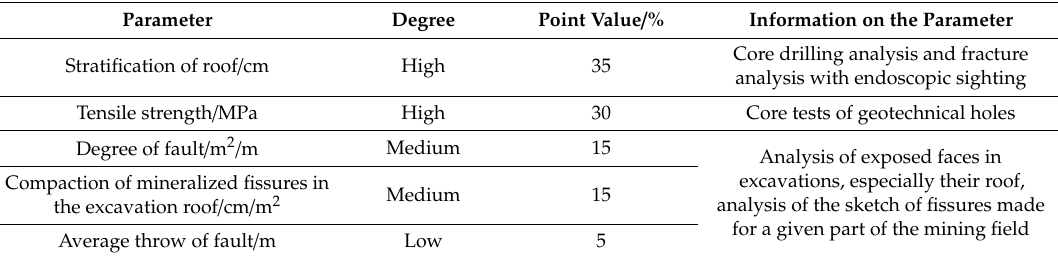
Table 3. Parameters characterizing roof rocks in the aspect of rock bolt support